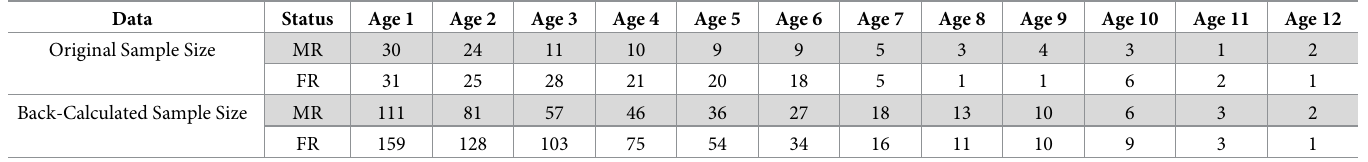
Table 1. Comparison of sample sizes between the original stocks of fish used for otolith ageing and the pooled stocks of fish that resulted from the MFBC